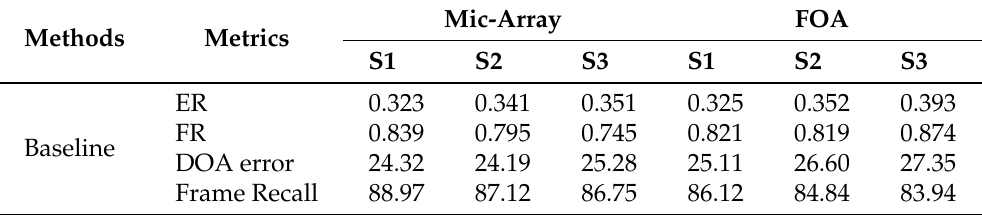
Table 5. Performance comparison between other similar methods and the proposed method in scenario-2 escalator ascending